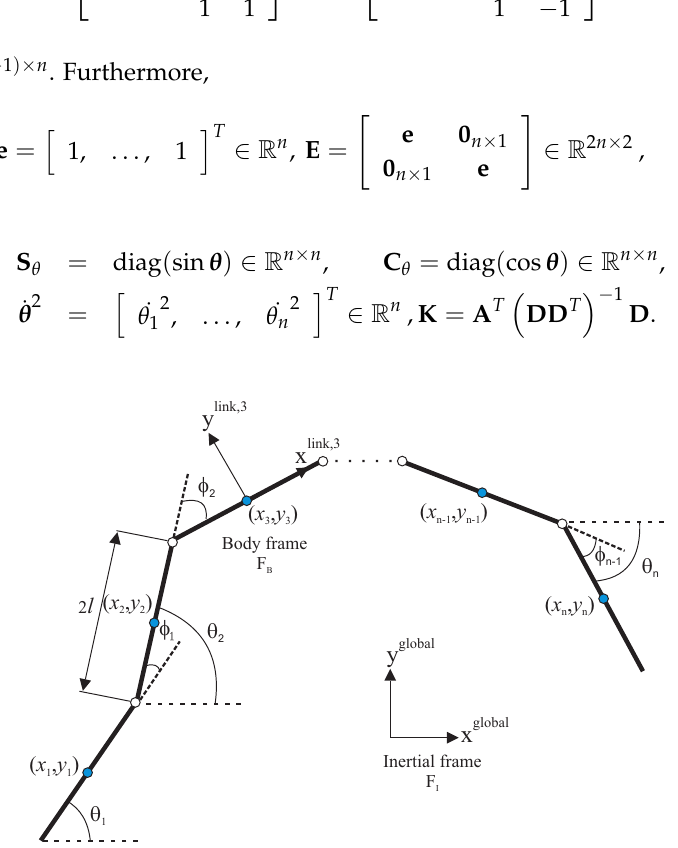
Figure 1. Kinematic parameters of the underwater snake robot.